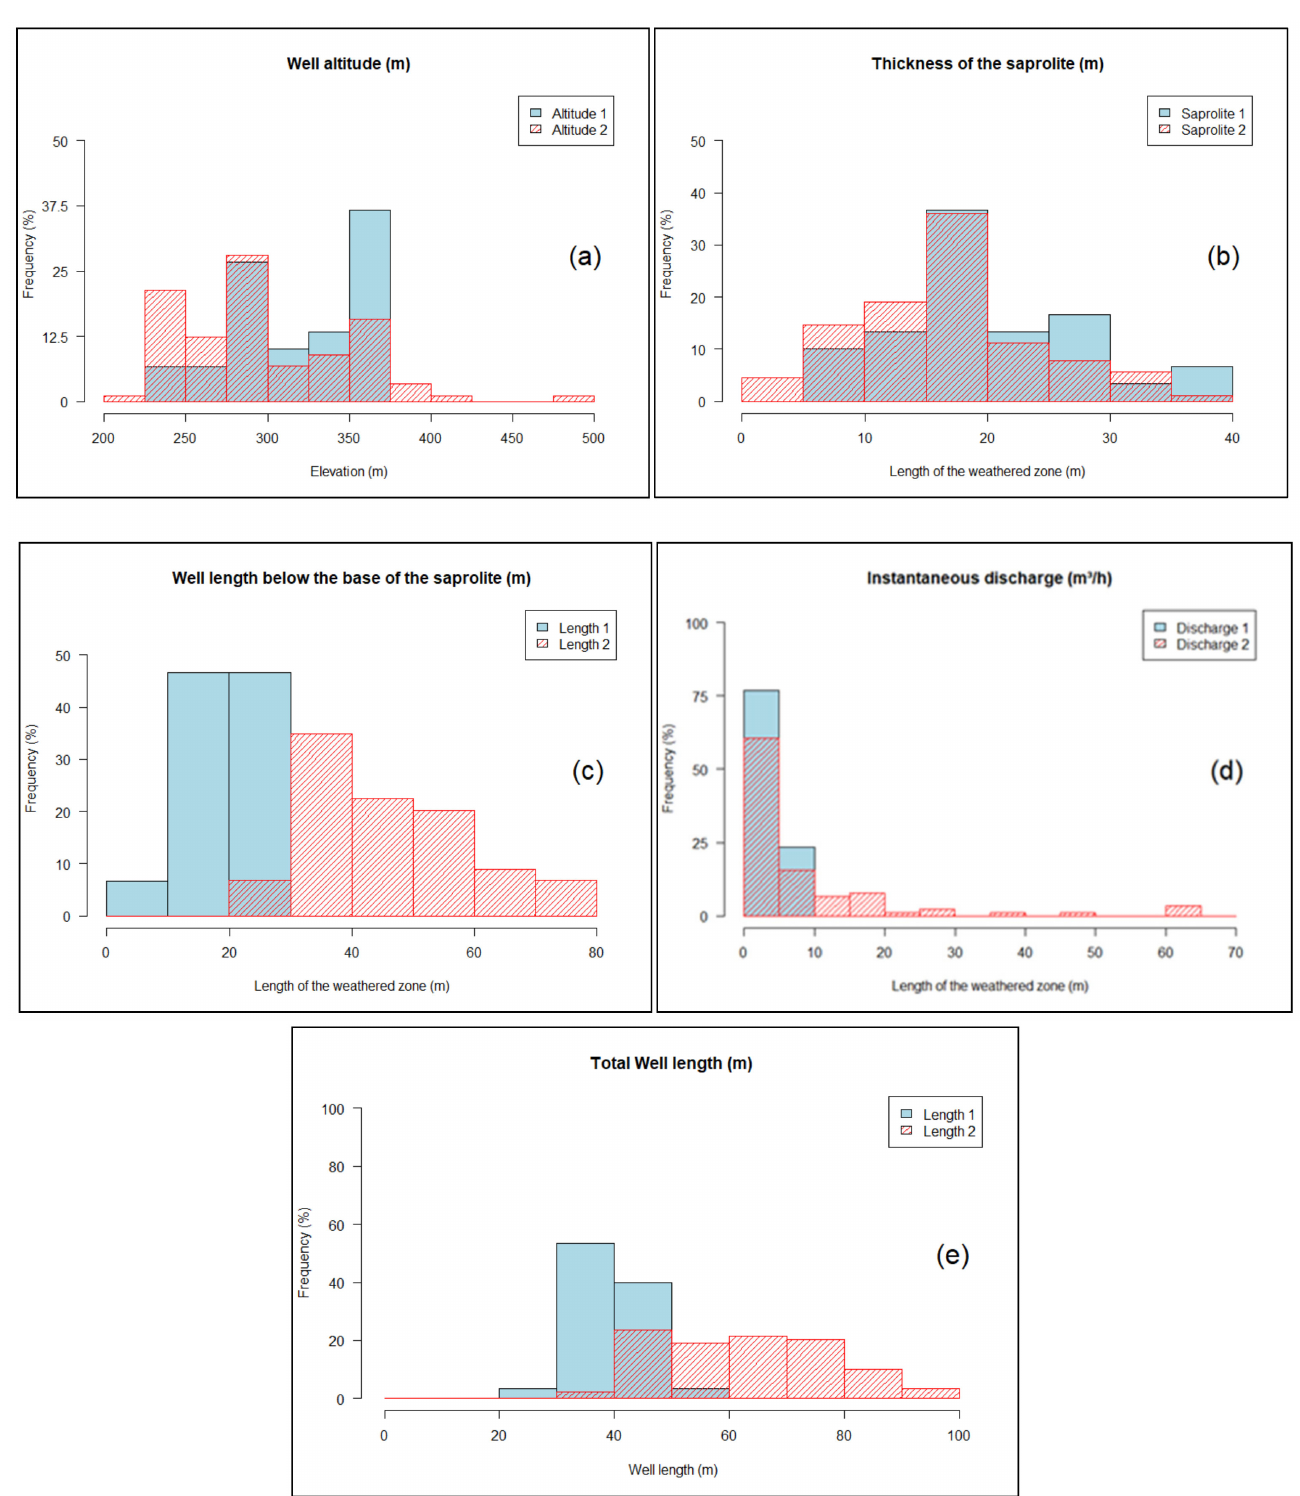
Figure 11. Histograms of altitude ( a ), thickness of the saprolite ( b ), well length below the base of the saprolite ( c ), instanta- neous discharge ( d ), total well length ( e ) of the boreholes for the two populations considered (parameter 1 = population 1; N = 30 (depth ≤ 27 m), parameter 2 = population 2; N = 89, (27 < depth ≤ 43 m) for Biotite granodiorite and Biotite metagranodiorite (N =